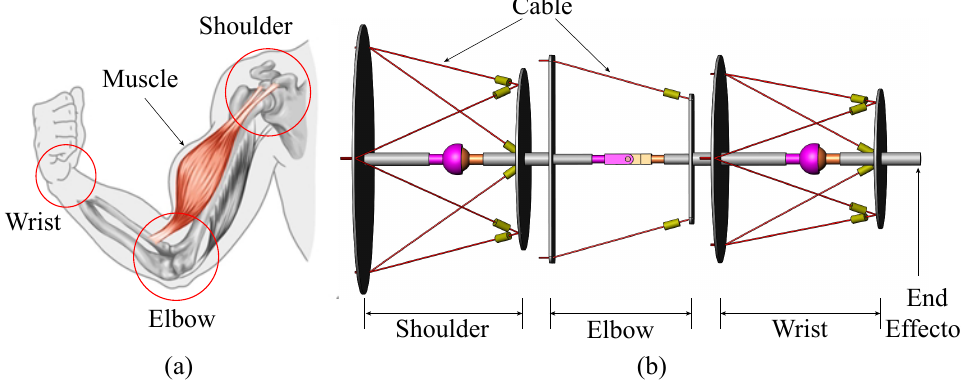
Figure 1. Concept design of the modular cable-driven human-like robotic arm: ( a ) structure of a human arm, ( b ) structure of the cable-driven human-like robotic arm